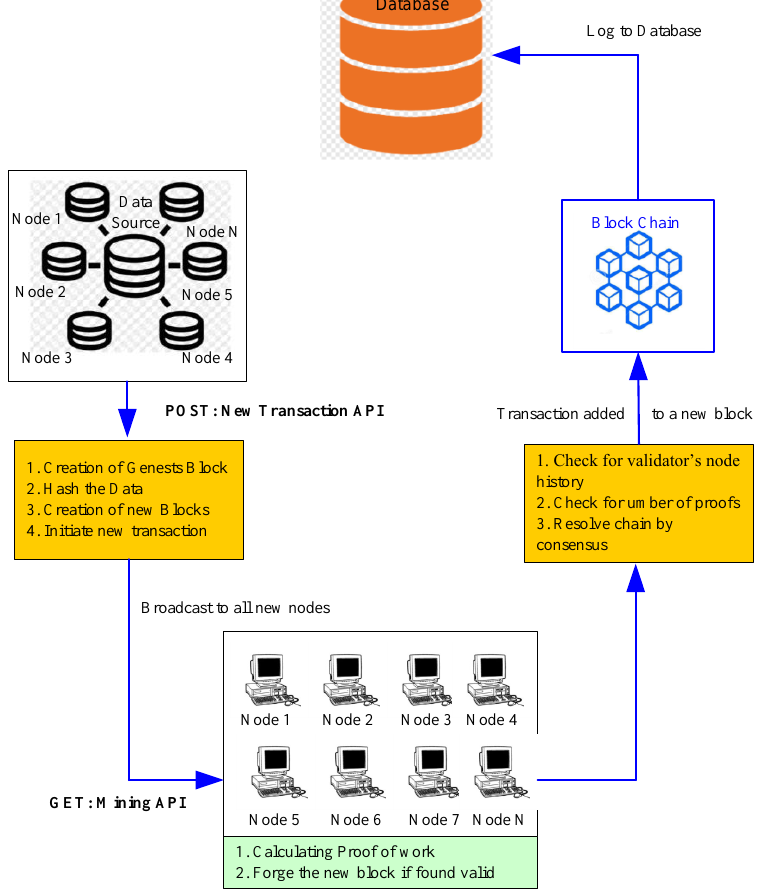
Figure 8. Process of blockchain connecting to the cloud server via API.